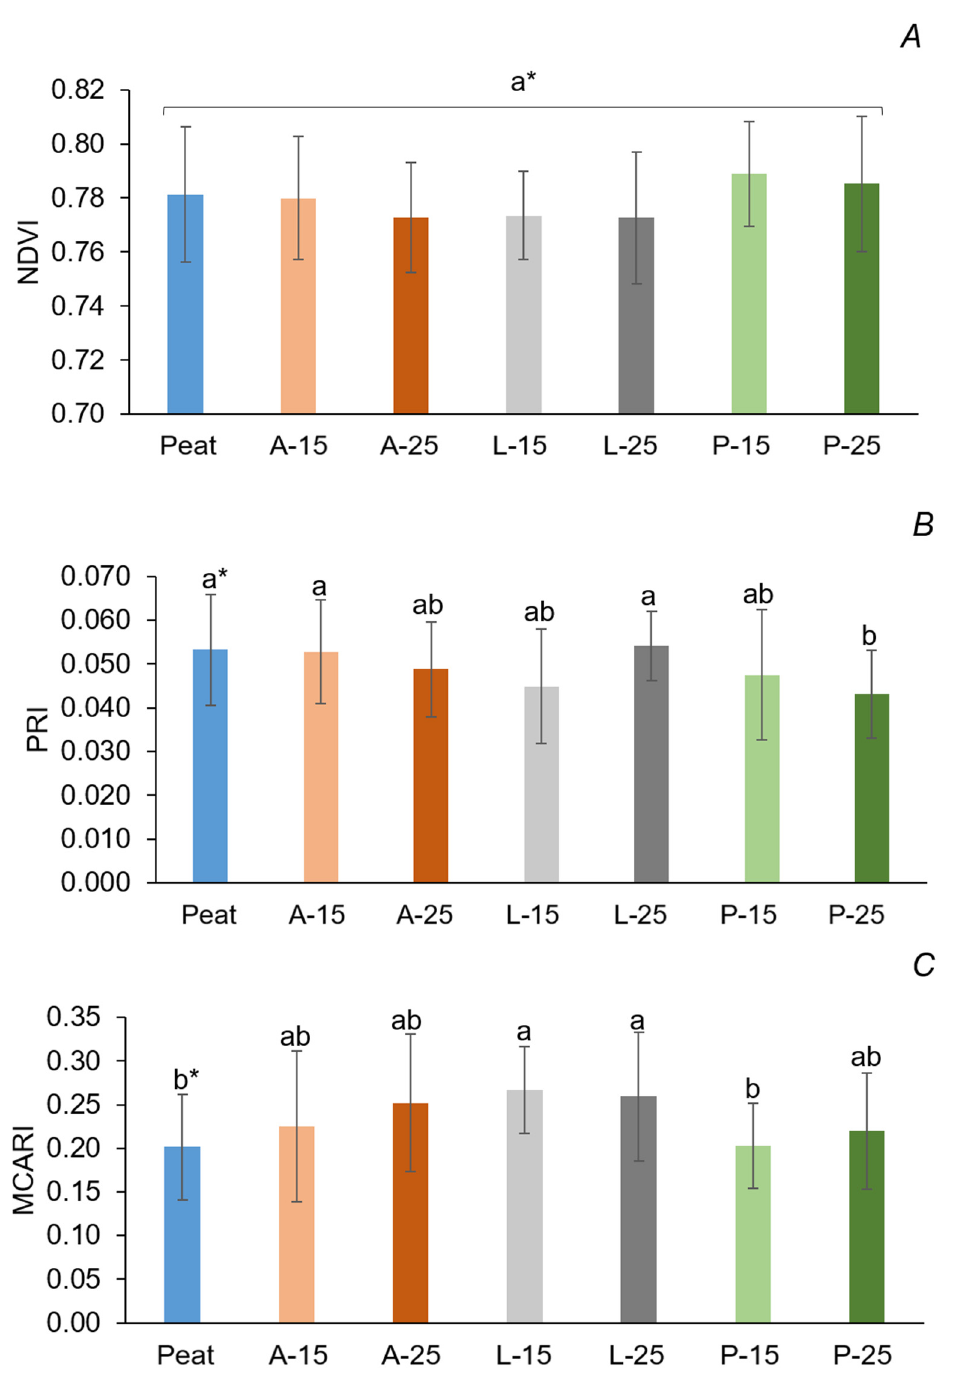
Figure 3. Vegetative indices NDVI ( A ), PRI ( B ) and MCARI ( C ), among different substrates, data represent mean ± SD. * Different letters indicate the significant differences among substrates according to Tukey’s HSD at p < 0.05 ( n = 15). A-15—A-SMS:Peat (15:85%), A-25—A-SMS:Peat (25:75%), L-